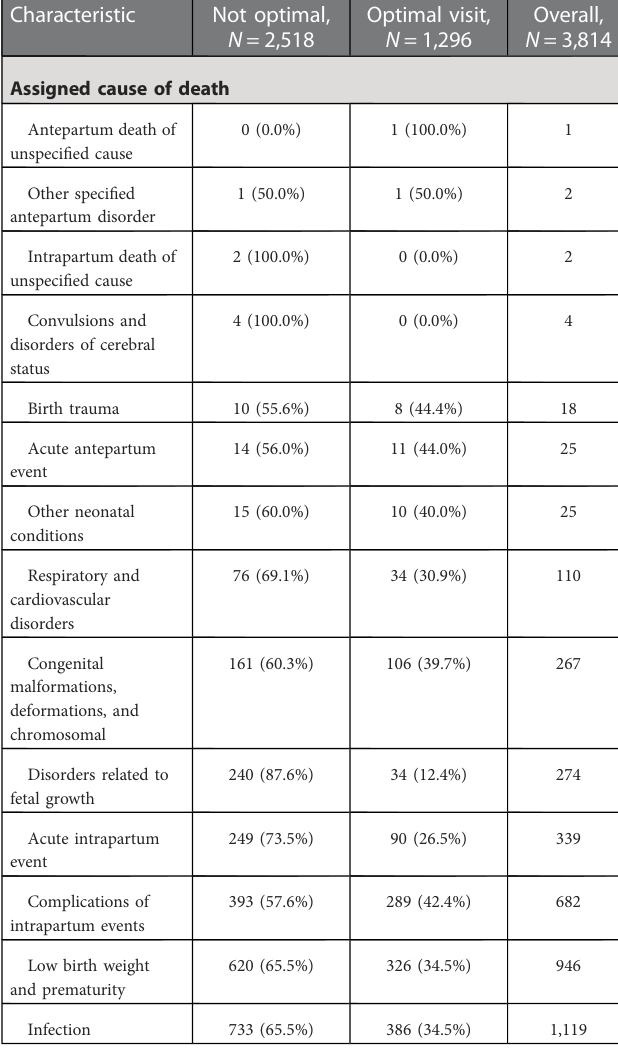
TABLE 5 Assigned cause of death by the level of ANC follow-up in Ethiopia, 2021. Characteristic